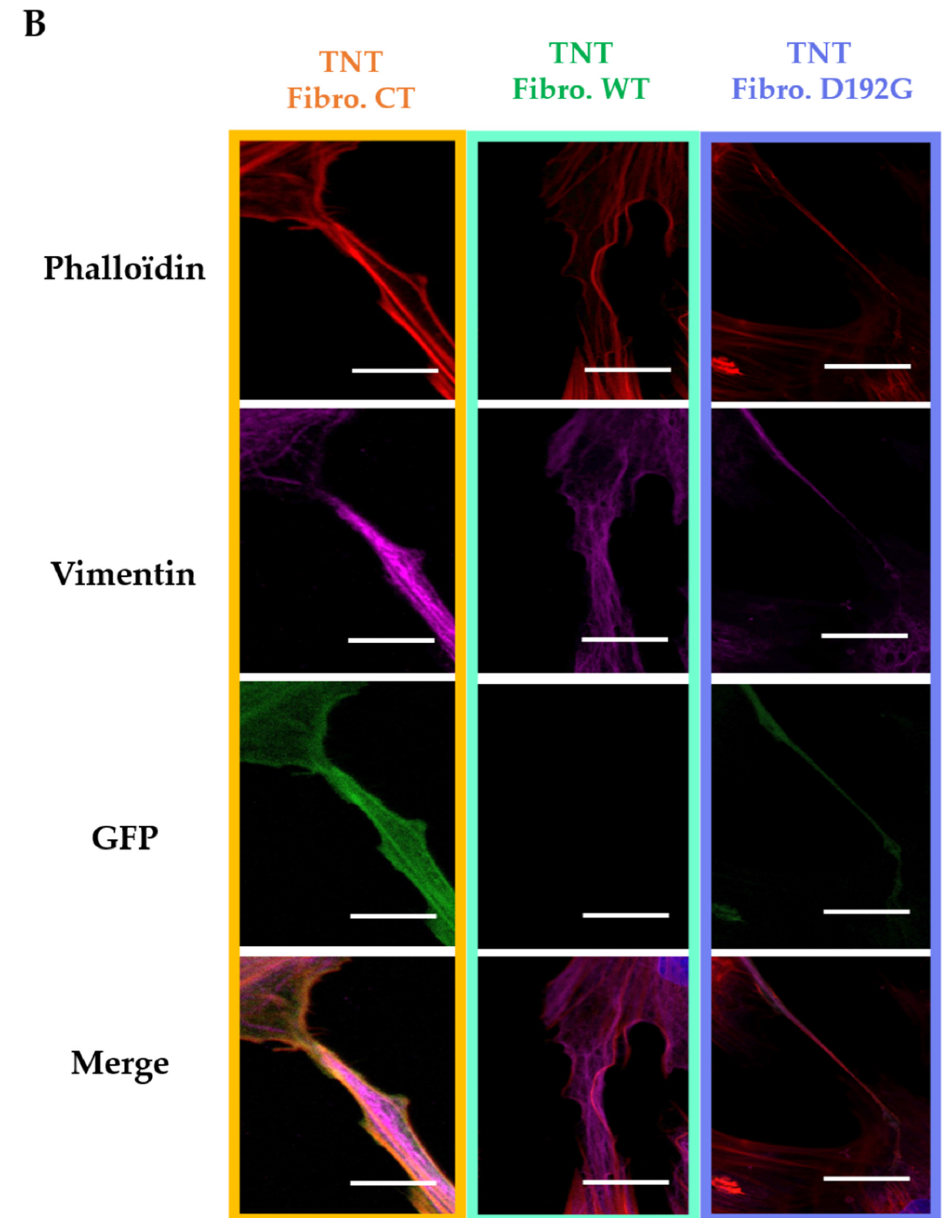
Figure 2. ( A ) Fluorescence staining of NRVF cytoskeleton. NRVF fluorescence staining in CT, WT, and lamin A/C D192G mutated condition with (i) Phalloidin to target both actin filaments and vimentin intermediate filaments, (ii) DAPI to target the nucleus, and (iii) green fluorescent protein (GFP) used as the transfection control after infection of adenoviral with, or without, the mutation lamin A/C D192 G. Scale bar (white), 10 µm. ( B ) Fluorescence staining of NRVF nanotubes. NRVF nanotubes’ fluorescence staining in CT, WT, and lamin A/C D192G mutated condition with (i) Phalloidin to target both actin filaments and vimentin intermediate filaments, (ii) DAPI to target the nucleus, and (iii) green fluorescent protein (GFP) used as the transfection control after infection of adenoviral with, or without, the mutation lamin A/C D192 G. Scale bar (white), 10 µm As far as the TNTs are concerned, when they were produced by Fibro-MT they displayed a “brittle” morphology with a thickness of 0.66 ± 0.36 µm (Figure 2B), while TNTs produced by Fibro-WT and Fibro-CT were thicker: 2.55 ± 1.29 µm and 2.63 ± 1.48 µm respectively. The cylindrical shape of membrane nanotubes results from a compromise between surface tension and bending rigidity (1). Taking the analogy between tethers and filopodia as a guide, the force that the cell membrane exerts on the cytoskeleton at the ends of the TNT can be calculated if we idealize the TNT as an actin bundle cylinder of radius r .